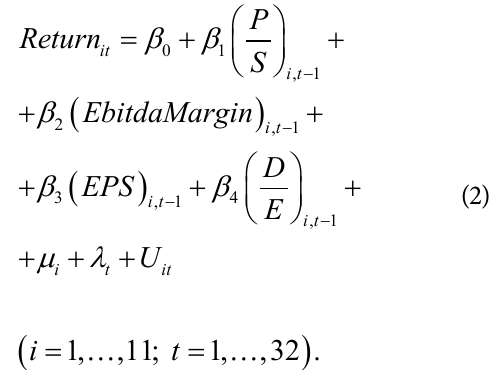
Table value of Chi-squared (4) = 9.488